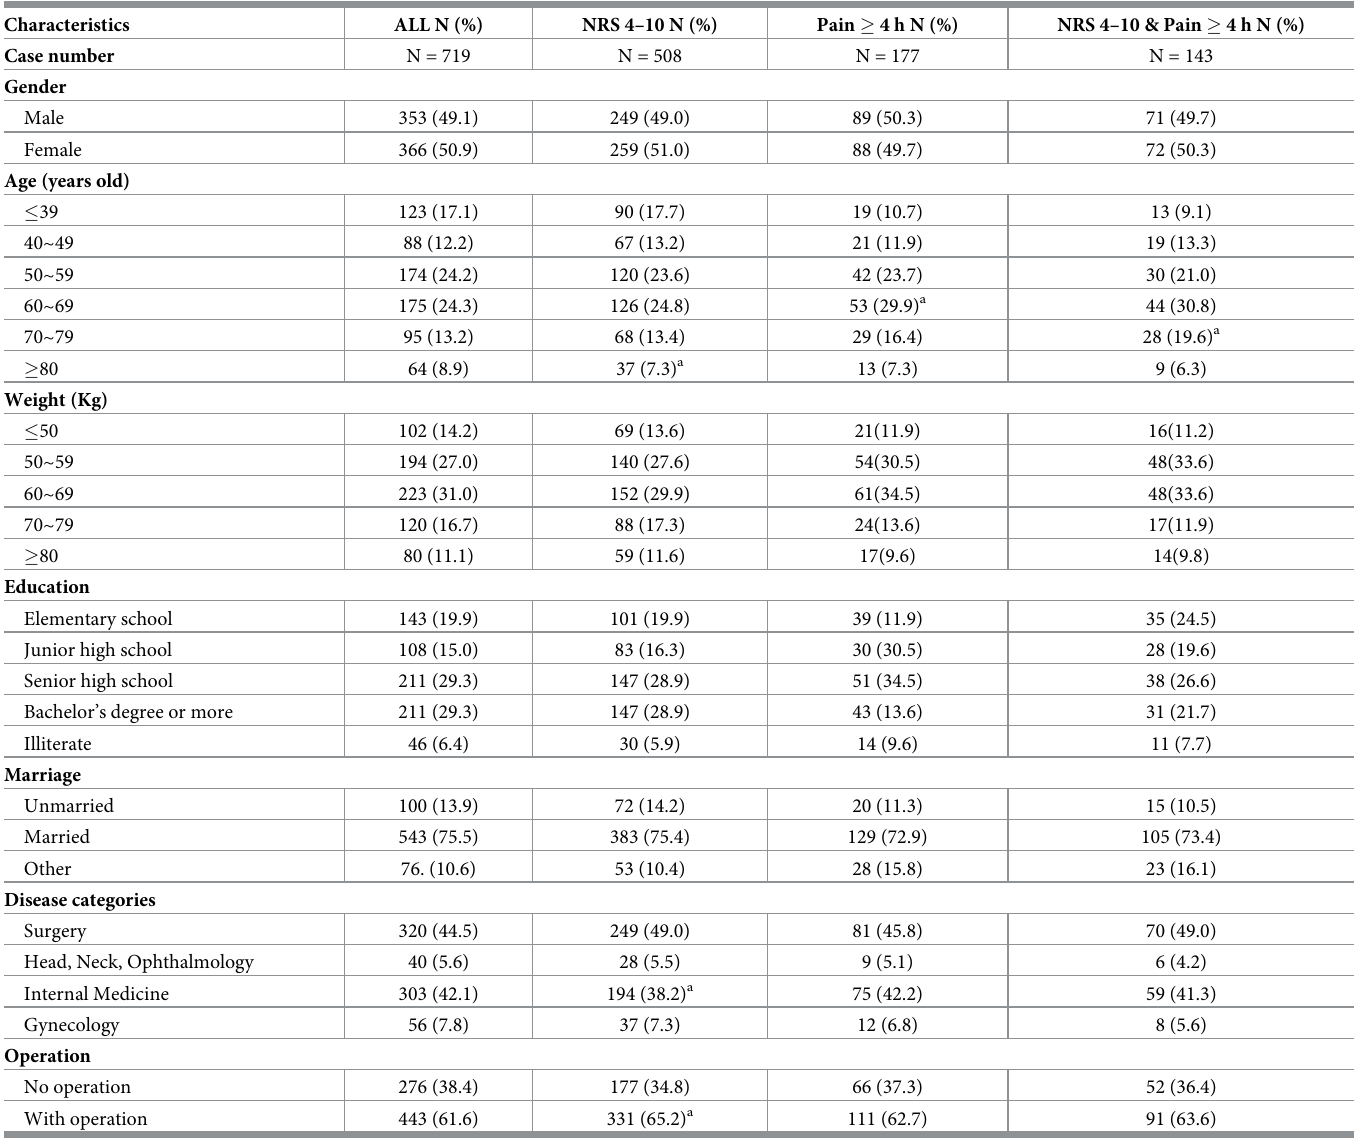
Table 2. Risk factors of pain (NRS 4–10), duration � 4 h and both.